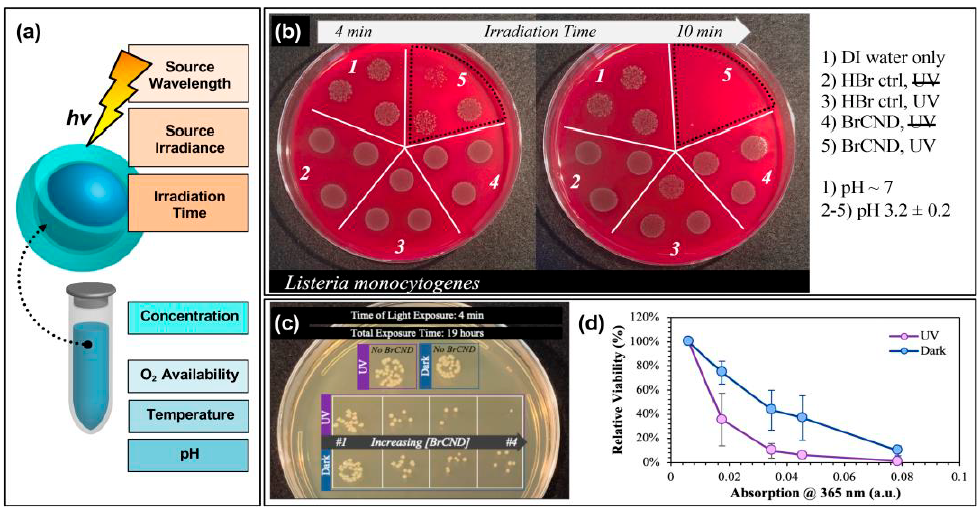
Figure 8. Parameters for tuning carbon nanodot photodynamic antimicrobial effects. ( a ) Schematic displaying some of the experimental parameters that must be adjusted to achieve maximal photodynamic antimicrobial effects from carbon nanodots. ( b ) Sample data set demonstrating the impact of irradiation time on the colony growth for Listeria monocytogenes exposed at 365 nm with brominated carbon nanodot (BrCND) photosensitizers. ( c , d ) Viability of Escherichia coli ( c ) grown on plates and ( d ) plotted as a function of photosensitizer concentration (plotted here by the BrCND sample absorption at 365 nm). Panels ( b – d ) adapted from Reference [56]. For additional details